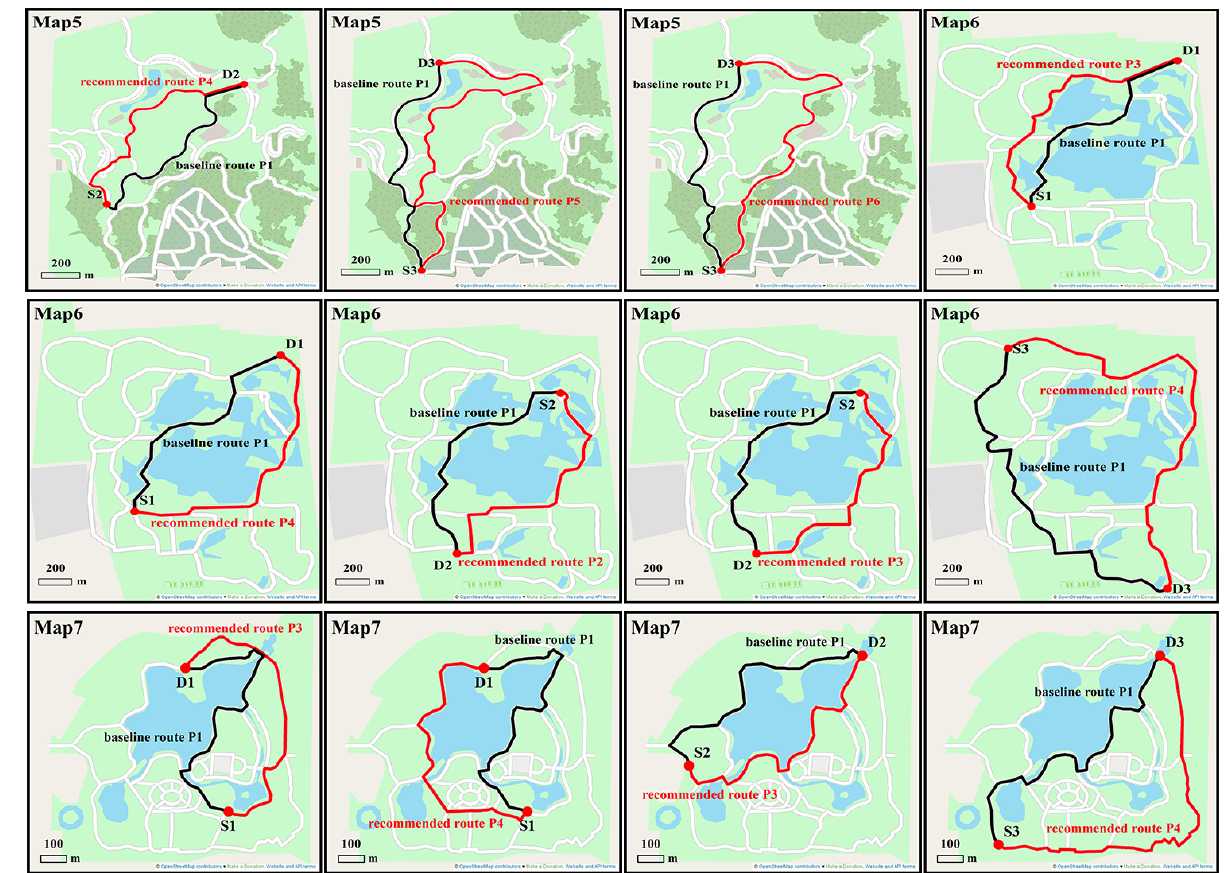
Figure 4. The baseline maps with recommended routes and baseline routes.